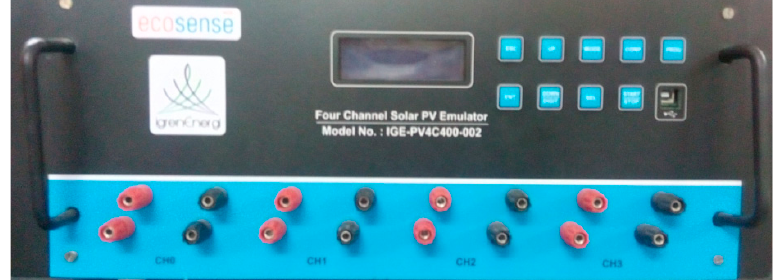
Figure 10. Solar PV emulator with four channels (CH1 to CH4).